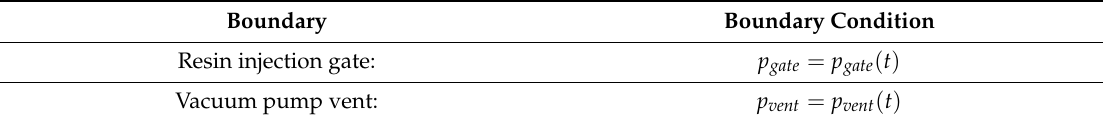
Table 3. The boundary conditions of Equation